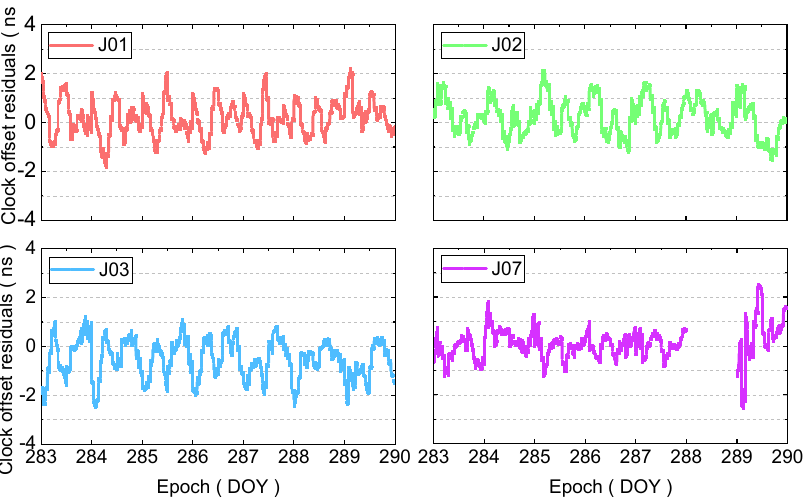
Figure 6. Clock offset difference time series of QZSS satellites from broadcast ephemeris. Table 3. Clock offset accuracy of each system (units: ns).